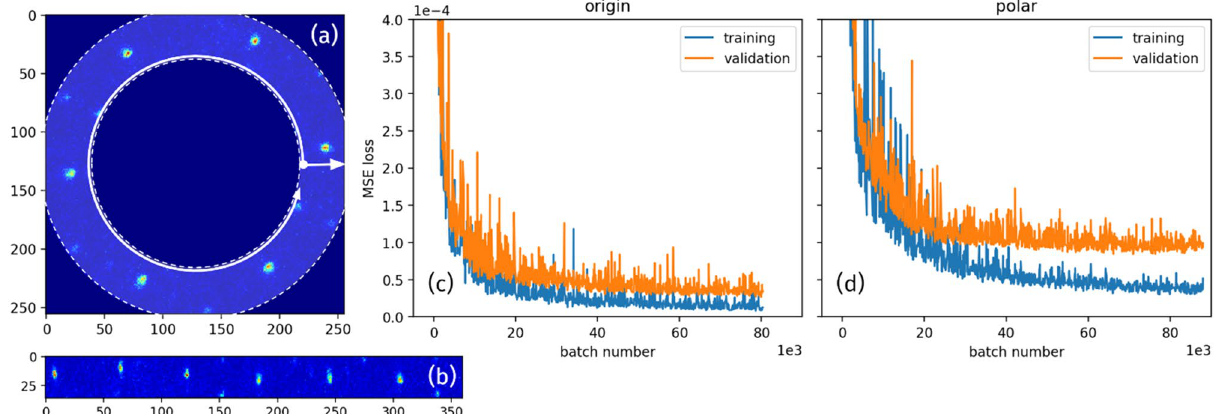
Figure 7. ( a ) An example of the original experimental image. The highlighted dashed ring area indicates the informative part of the image. The two arrows show the axes of the polar coordinate that the ring to be transformed to. ( b ) The polar-transformed image of the ring area in ( a ). ( c ), ( d ) Training loss (blue curves) and validation loss (orange curves) for the original images and the polar images,